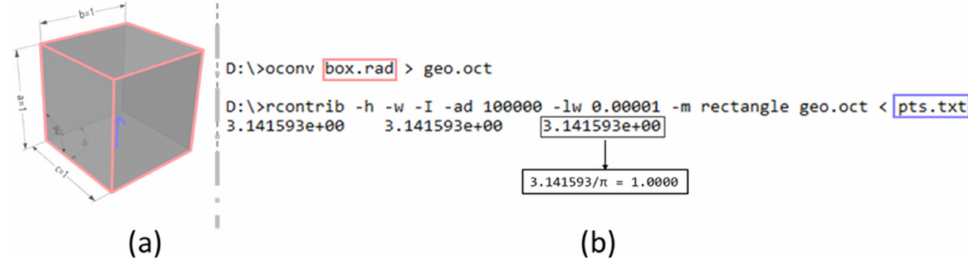
Figure 14. View factor between a differential surface, indicated by the purple arrow in ( a ), and surfaces of a box that encloses it. The corresponding calculation is shown in ( b